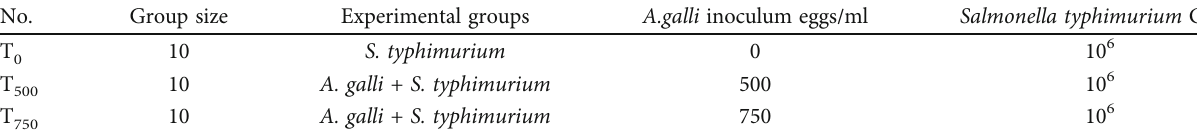
Table 2: Experimental design-2.